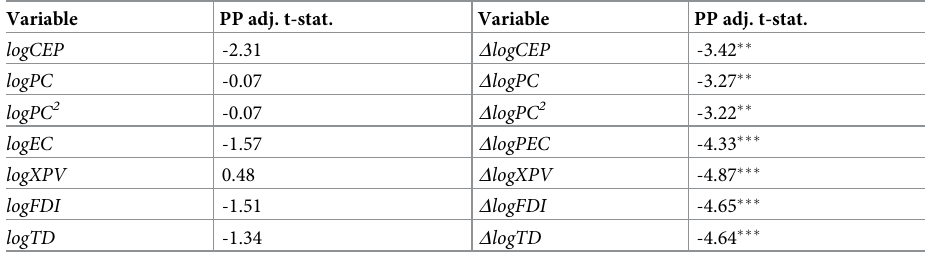
��� and �� indicate significance at the 1% and 5% levels, respectively.